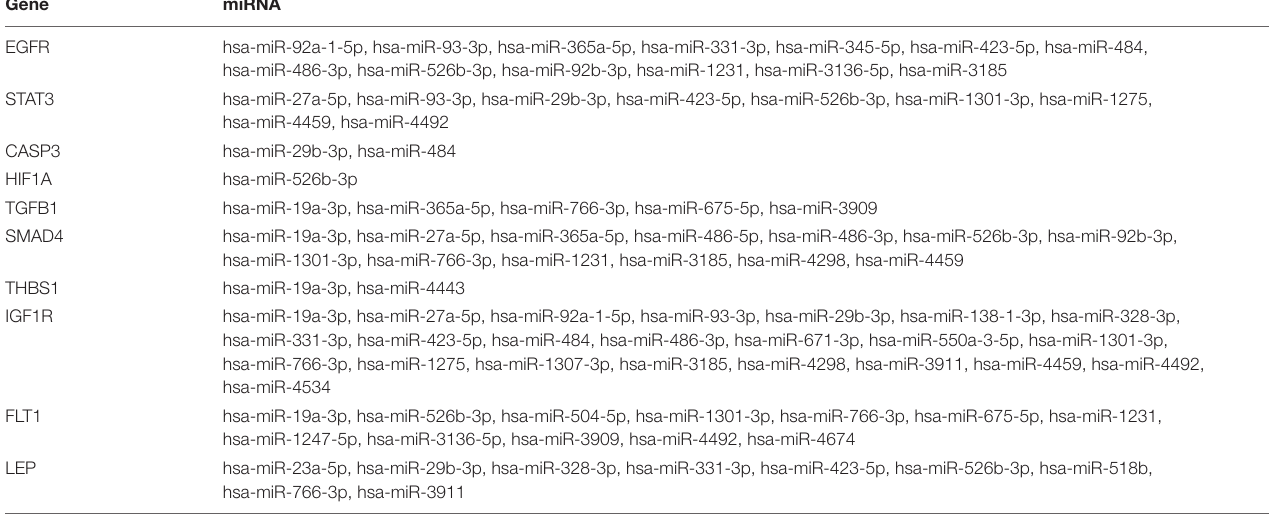
TABLE 2 | miRNAs target top 10 hub genes related to hypoxia.